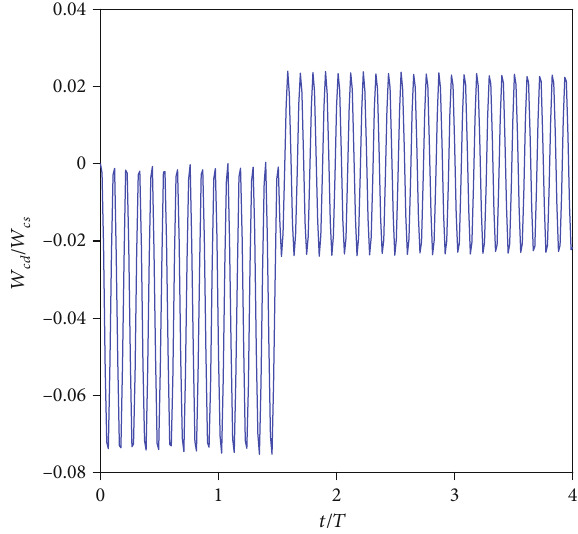
= 1 : 5 T , x / L = ð 0 : 6,0 : 9 Þ d a